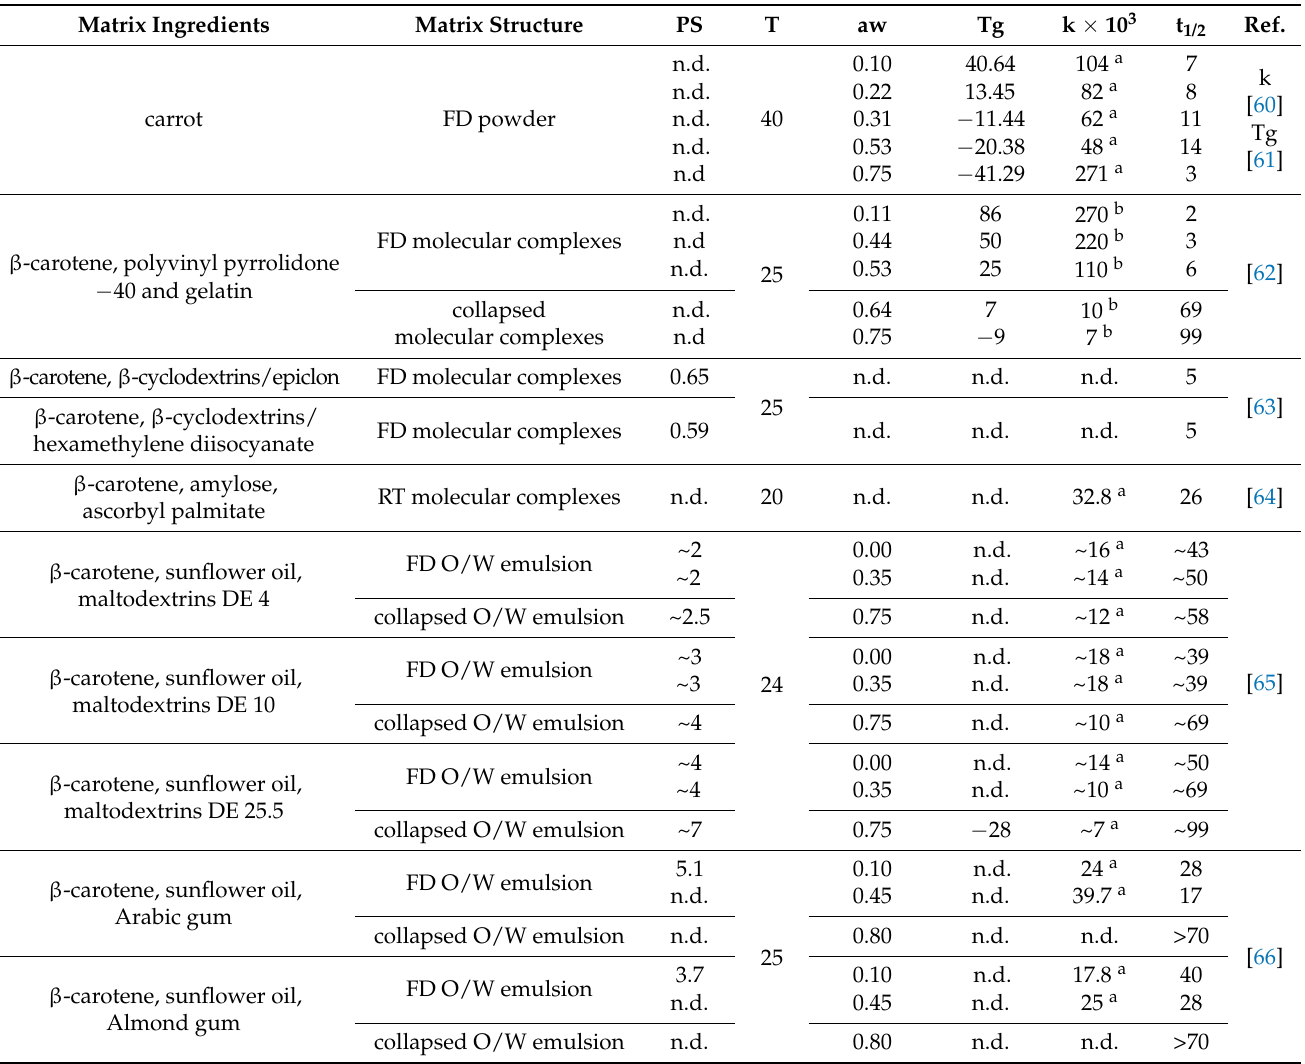
Table 1. Dried systems for the delivery of β -carotene: matrix ingredient, structure, average par- ticle size (PS, µ m), water activity (aw), glass transition temperature (Tg, ◦ C), degradation